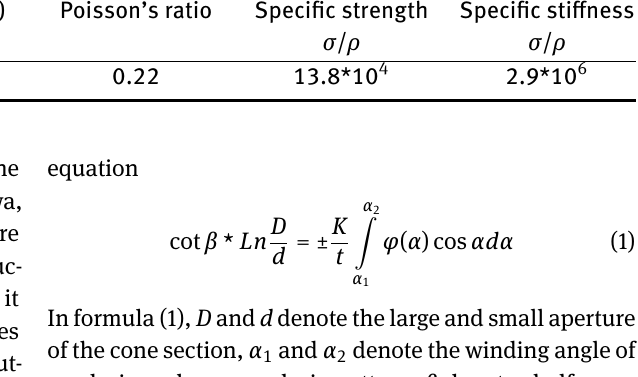
Table 2: Performance parameters of glass fiber Elastic Modulus